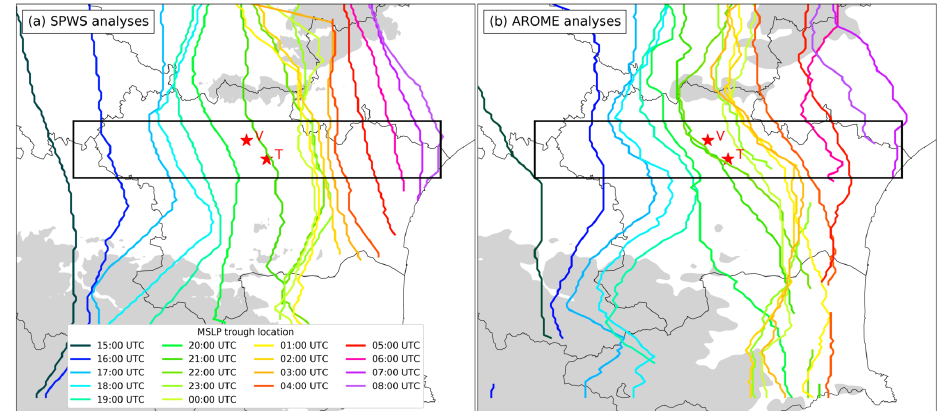
Figure 15. Location of the MSLP trough as a function of time between 15:00UTC on 14 October and 08:00UTC on 15 October indicated by (a) SPWS analyses and (b) AROME-France analyses. The Aude valley domain is indicated by the black box. Stars annotated “T” and “V” show the locations of Trèbes and Villegailhenc, respectively, which are two towns that were severely damaged. Terrain above 750ma.s.l. is shaded in